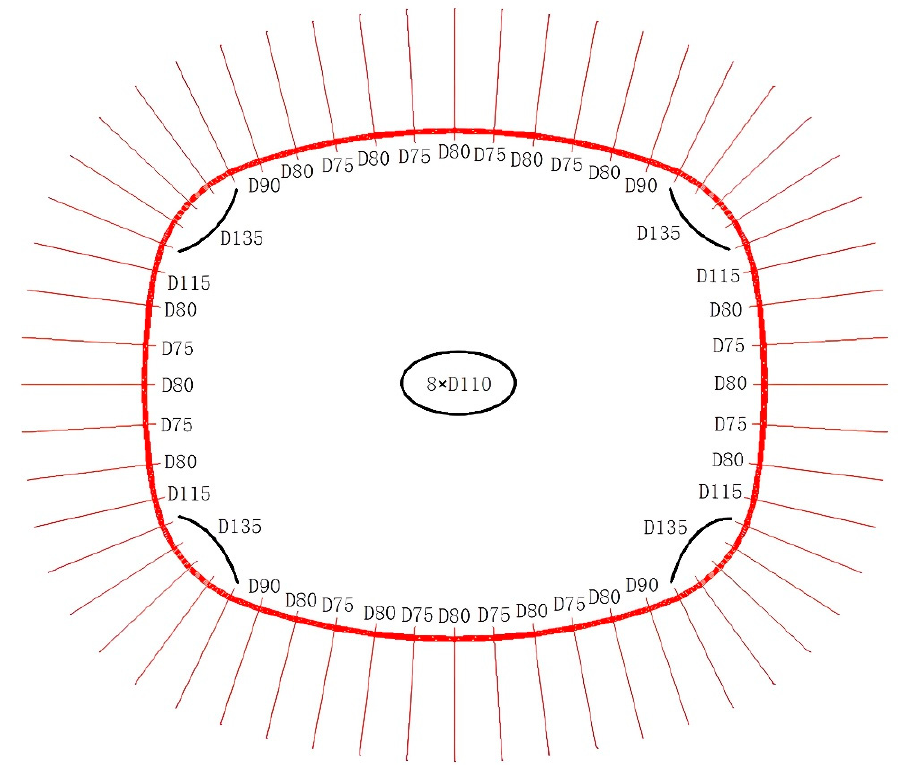
Figure 4. Layout of cable net. Table 1. Cable materials and specifications.